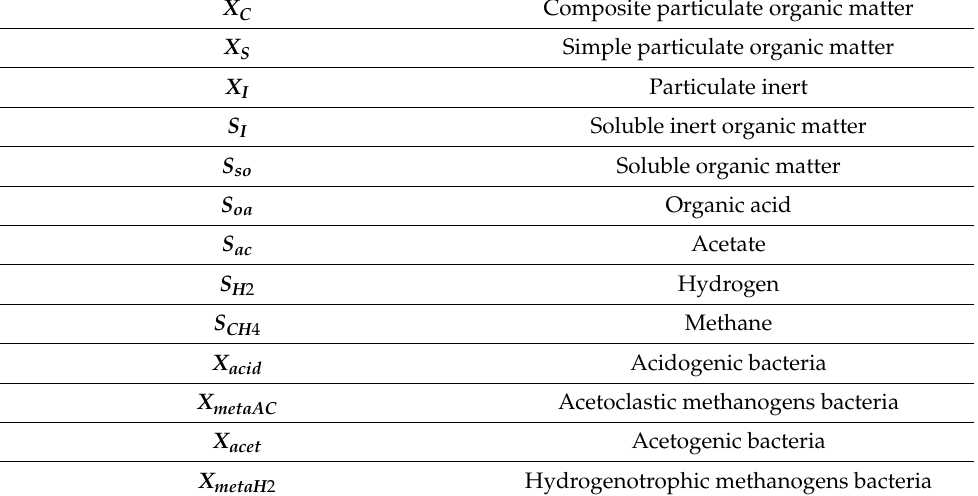
Table 1. Components of OFMSW.